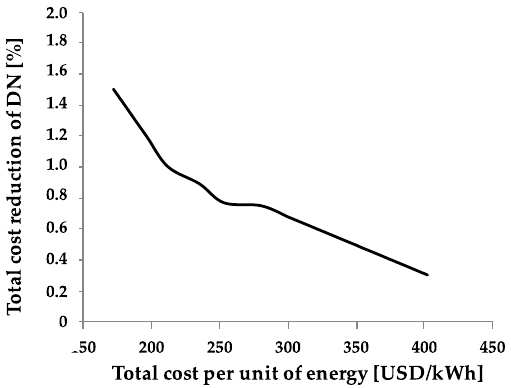
Figure 4. Total cost reductions for the distribution network (DN) considering the SB.